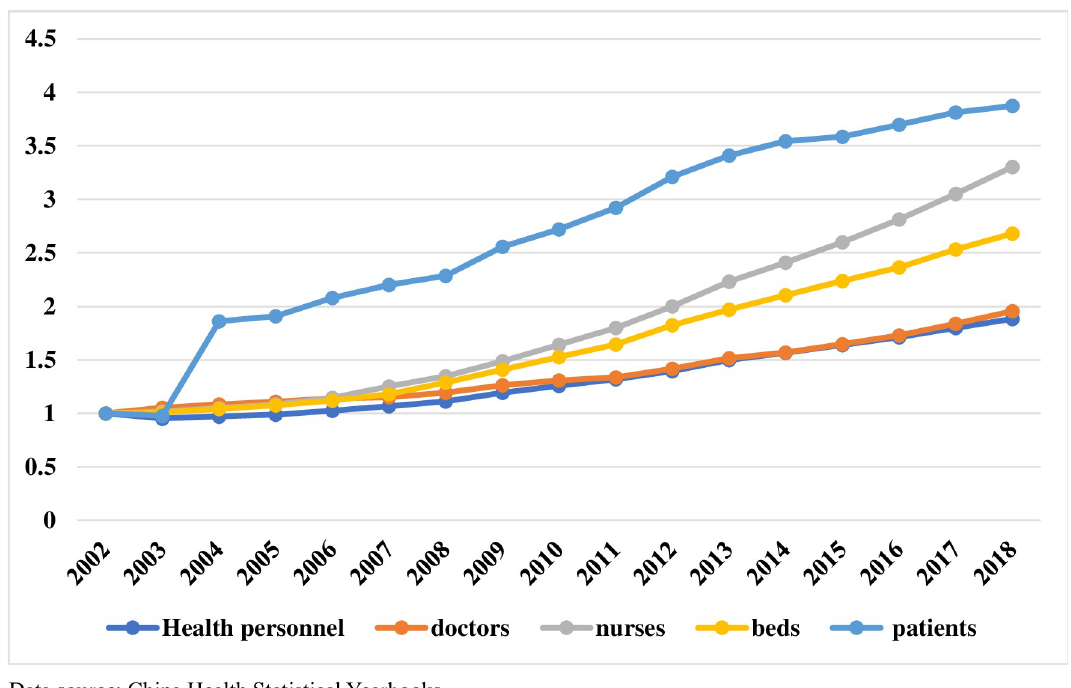
Fig 1. Health personnel, beds, and patient statistics in China investigated from 2002 to 2018. Y-axis represents annual growth rates.